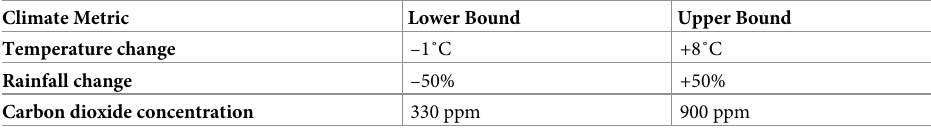
Table 3. Climate metric ranges for C3MP climate sensitivity